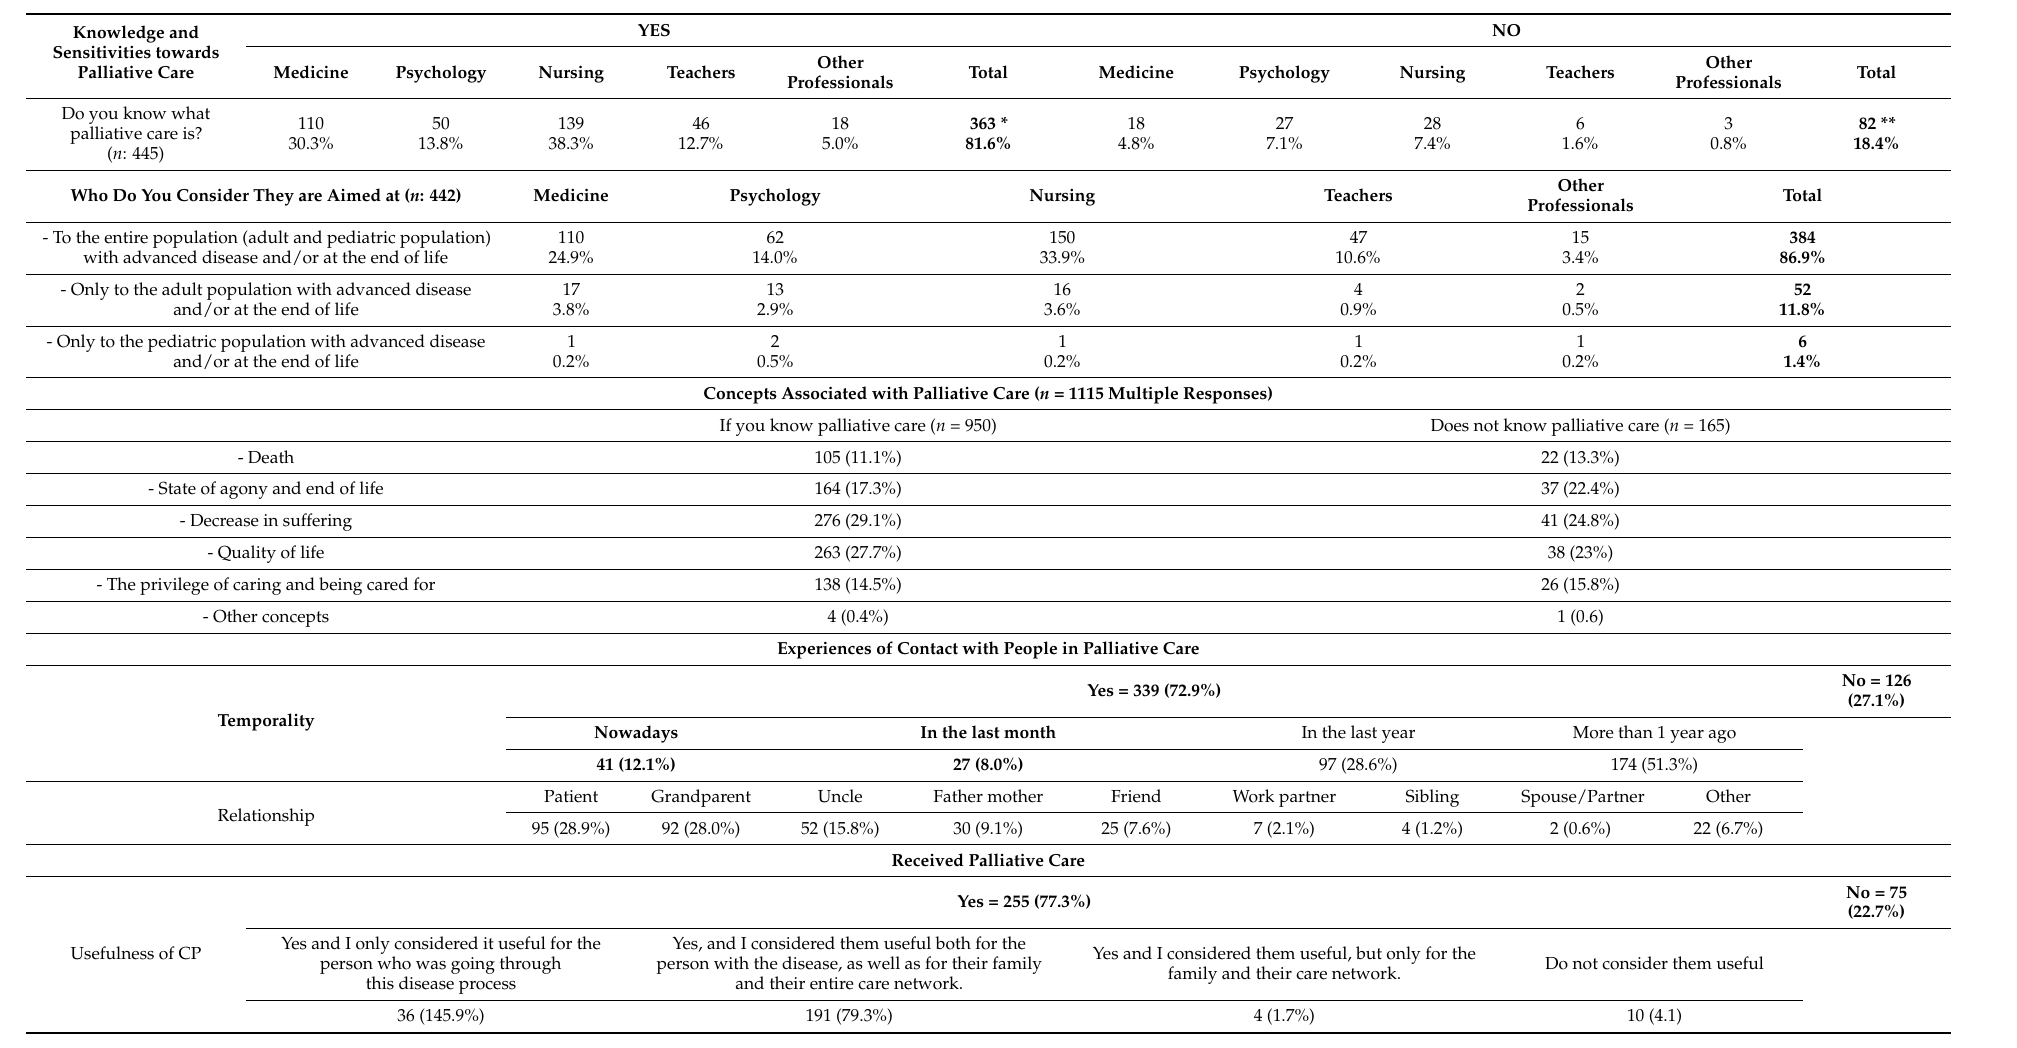
Table 2. Level of knowledge and sensitivities of the population about the care of people at the end of